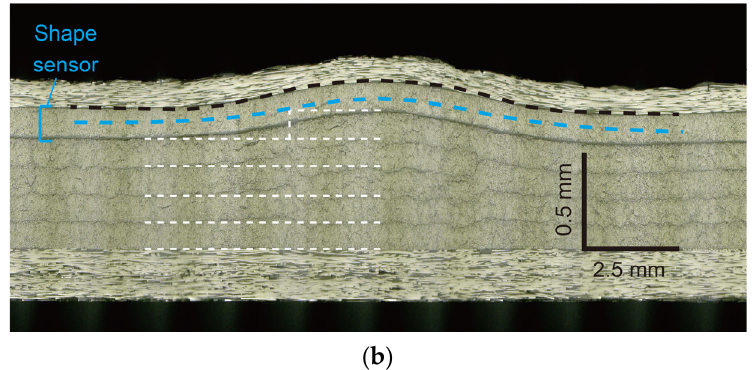
Figure 16. Cross-sectional micrographs of the specimen after curing. Note that the photos were com-